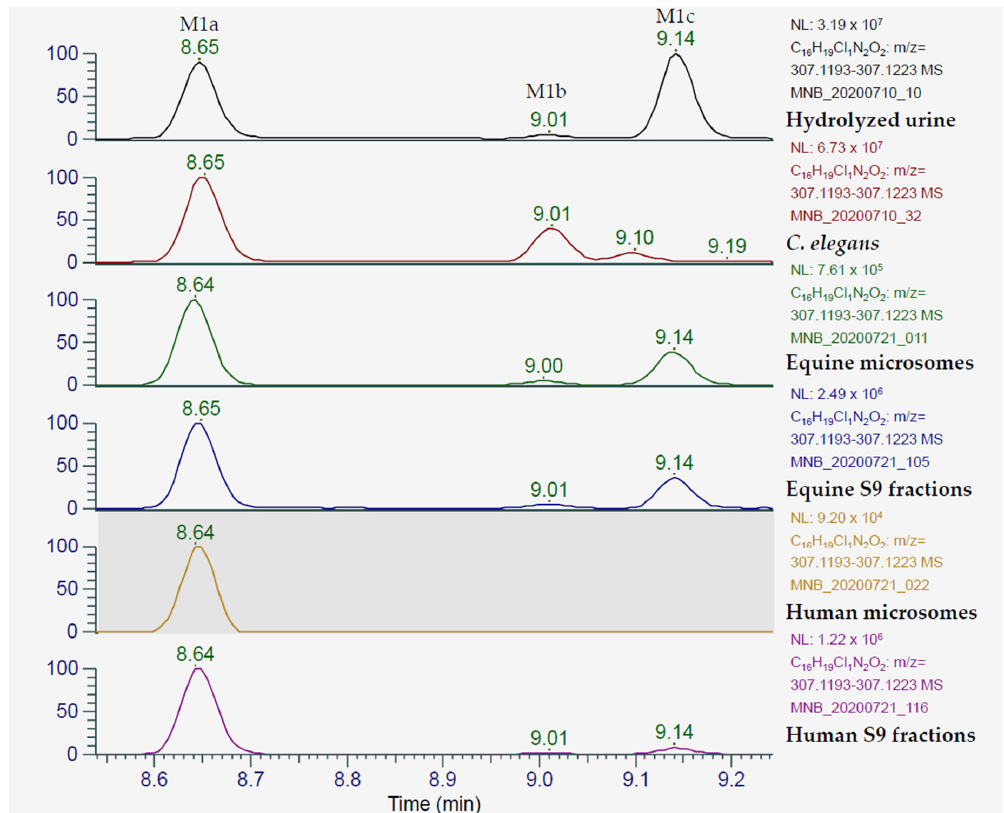
Figure 6. Extracted ion chromatograms of monohydroxylated ACP-105 [C 16 H 20 ClN 2 O 2 ] + that present the metabolites detected in hydrolyzed urine, C. elegans incubates and incubates of equine and human microsomes and S9 fractions. In hydrolyzed urine, the peak at 8.65 min represents metabolite M1a, the peak at 9.01 min represents the metabolite M1b and the peak at 9.14 min represents the metabolite M1c. The figure shows the retention time in minutes ( x -axis) and the relative mass spectrometric intensity ( y